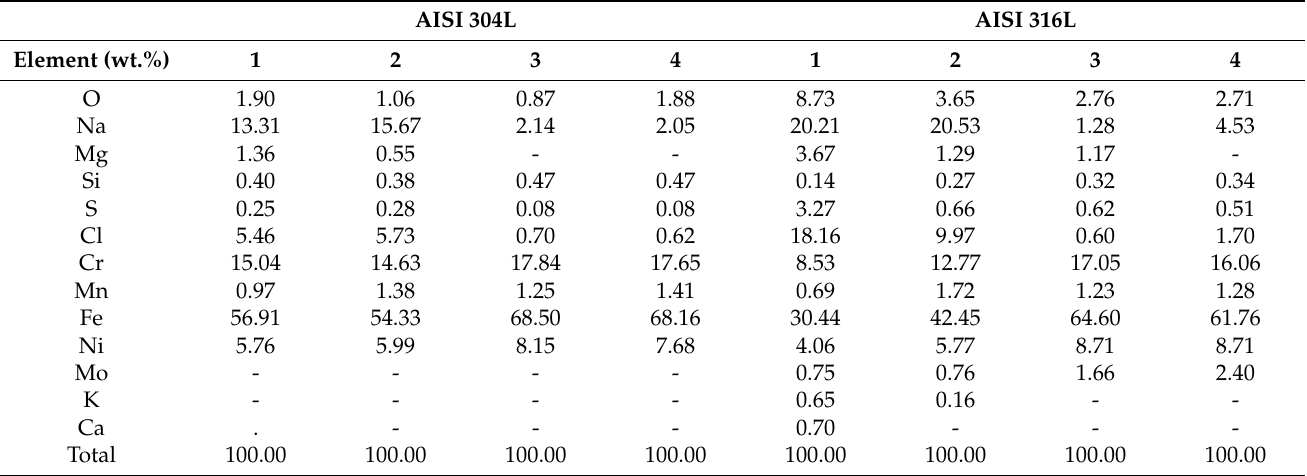
Table 8. Elemental composition on marked parts of the surface of ALSI 304L and AISI 316L steels after potentiodynamic polarization measurements in seawater with 40 ppm S 2 - ions at 298 K.